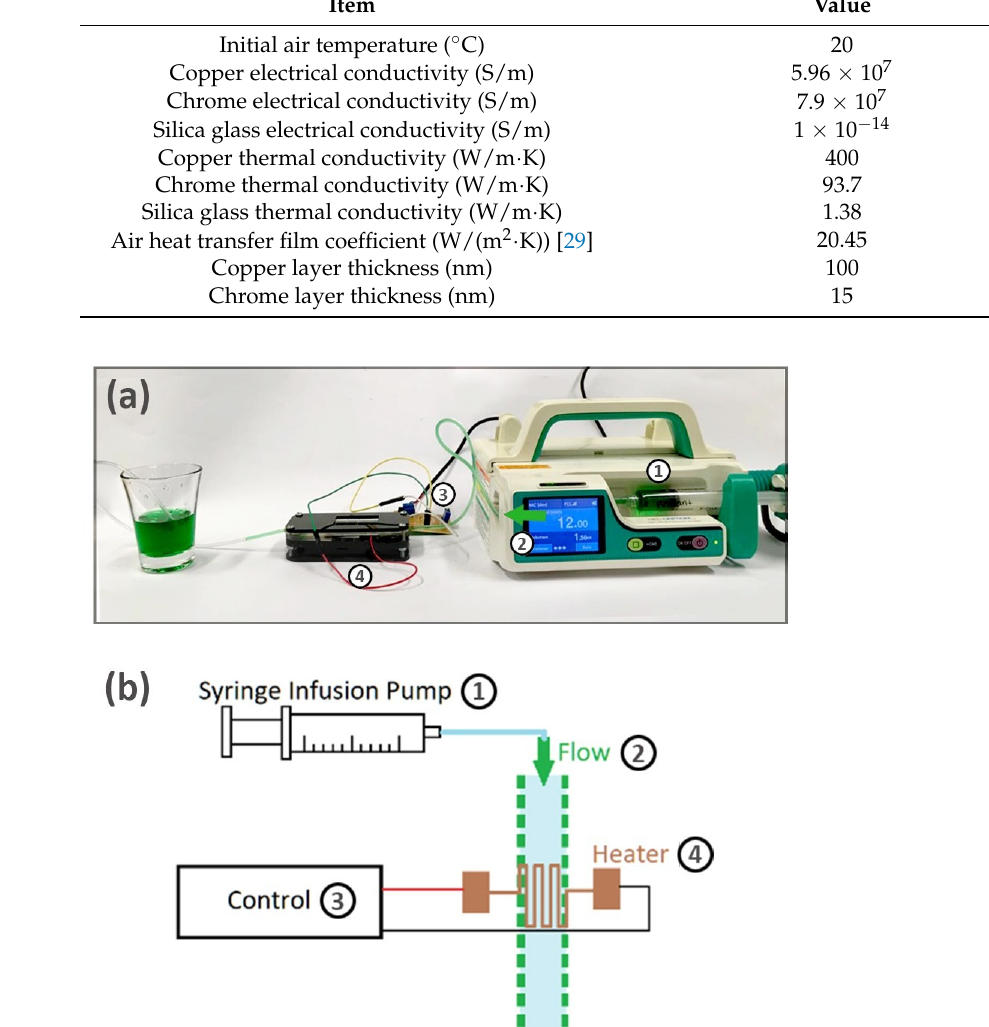
Table 2. Measurements and common theoretical calculations of the copper-chrome-based heater.